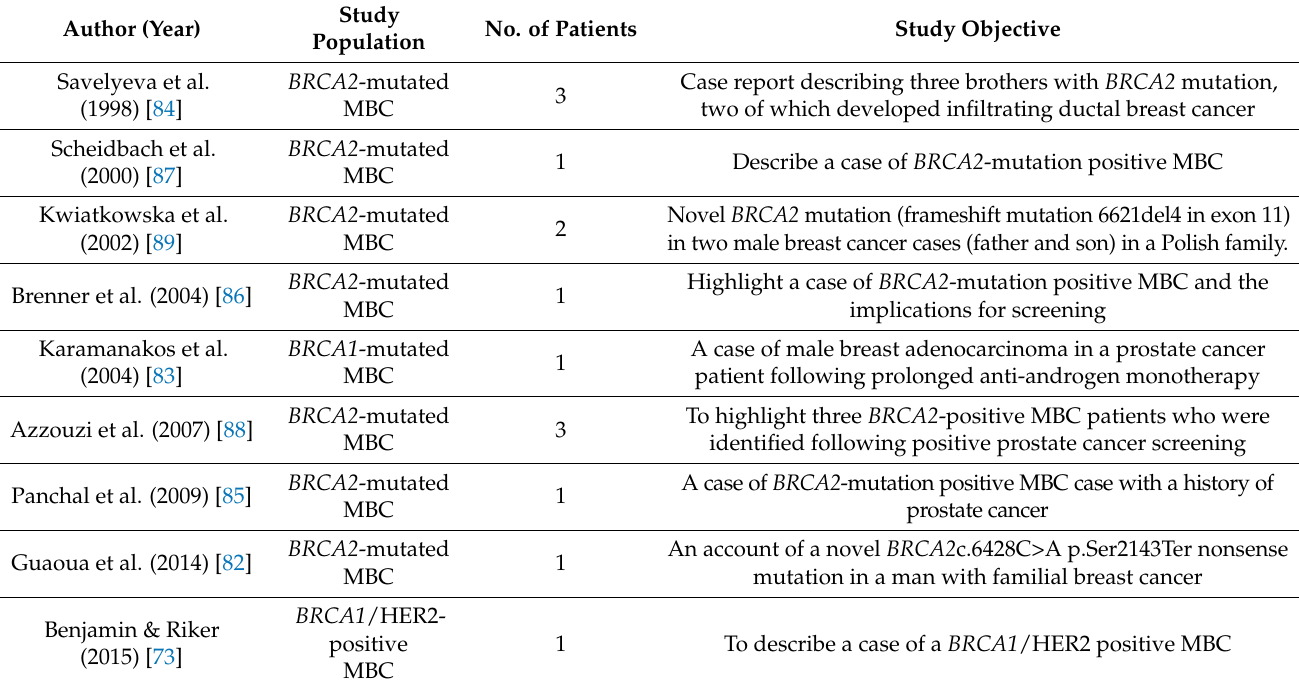
Table 2. Summary of case studies involving BRCA -positive MBC